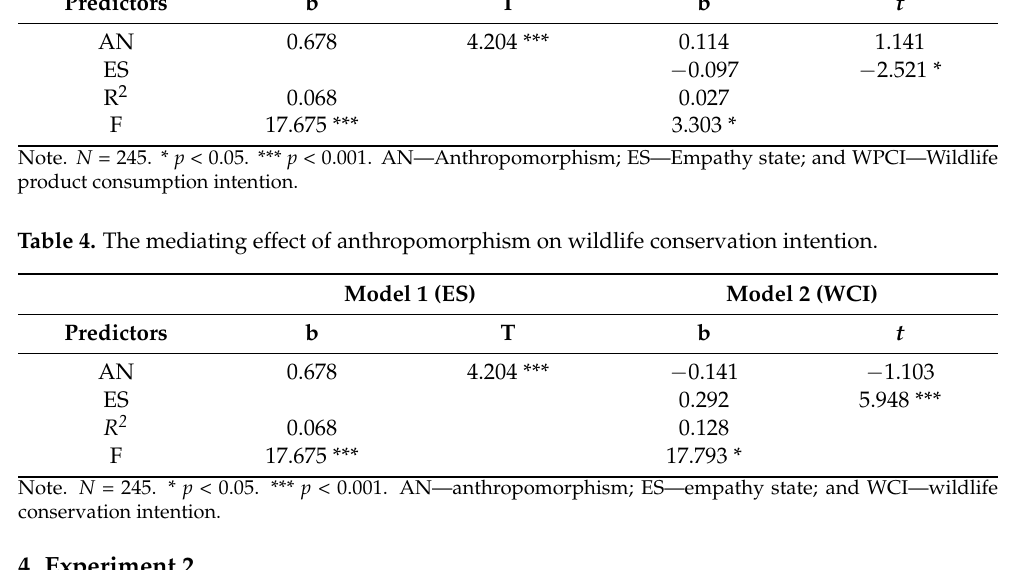
Table 3. The mediating effect of anthropomorphism on wildlife product consumption intention. Model 1 (ES) Model 2 (WPCI) Predictors b T b t AN 0.678